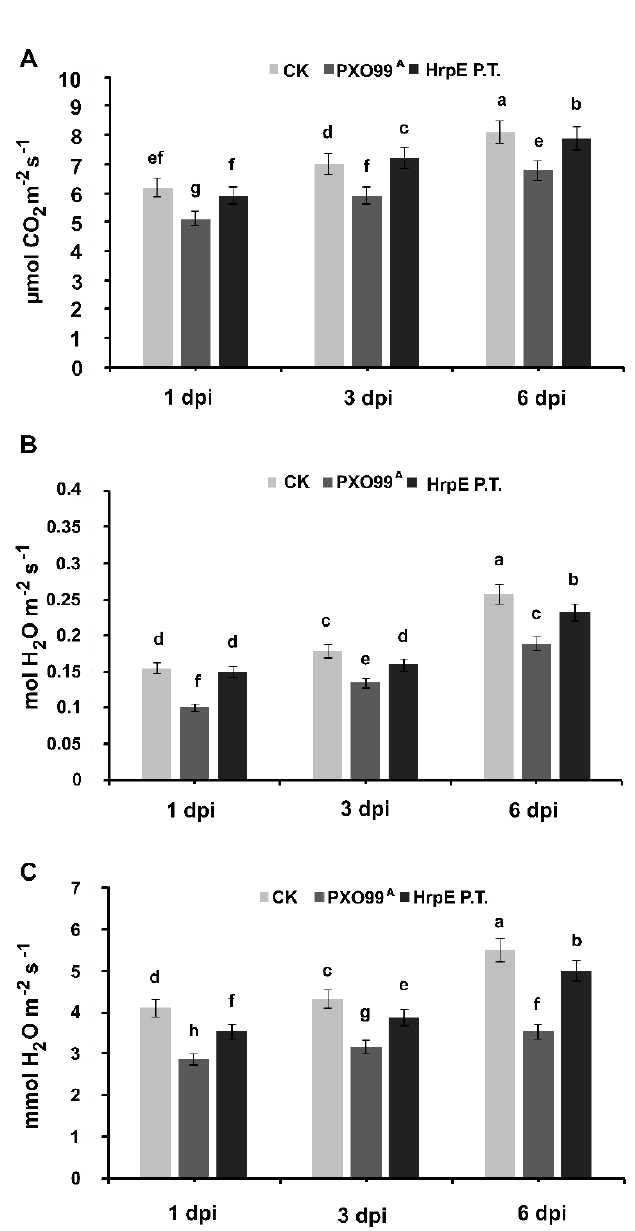
Figure 8. Photosynthesis rate of rice leaves pre ‐ treated with HrpE at different time intervals ( A ); stomatal conductance ( B ); and transpiration rate ( C ). dpi = days post inoculation. Error bars show standard deviations of the means. Lower case letters above the columns indicate a significant difference at p < 0.05. All the experiments were conducted in triplicate with similar results each time.